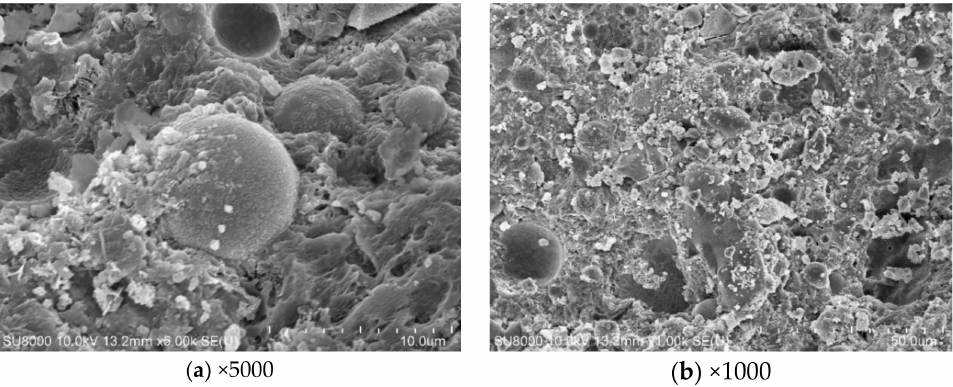
Figure 14. SEM images of sample containing VF. ( a ) × 5000. ( b ) ×